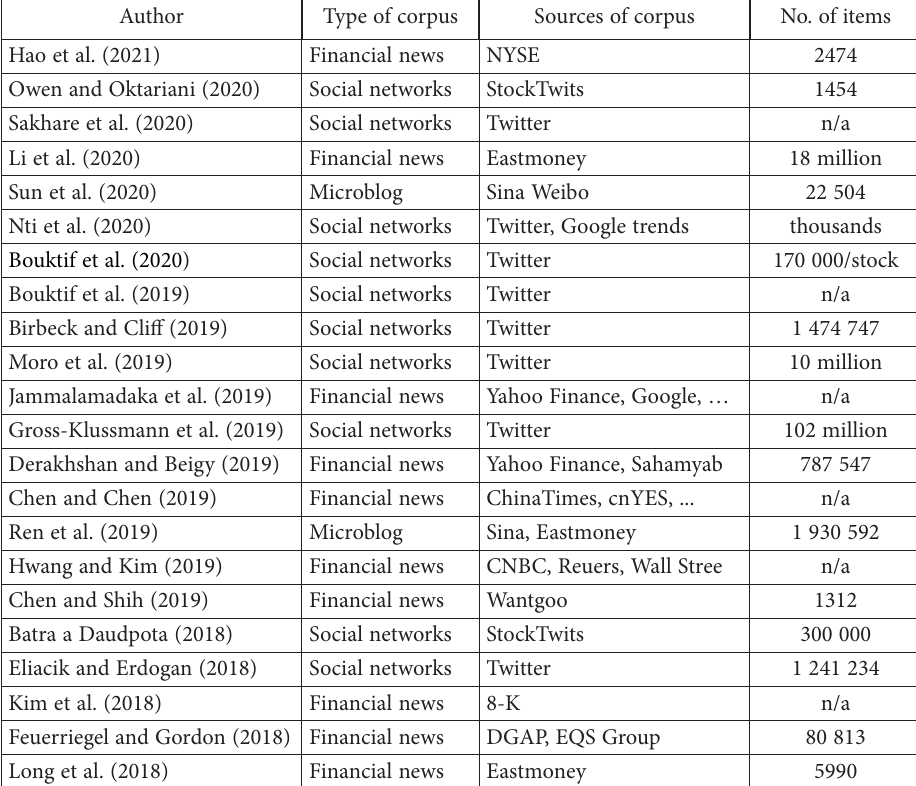
Table 1. Sources of text unstructured data (source: Janková,